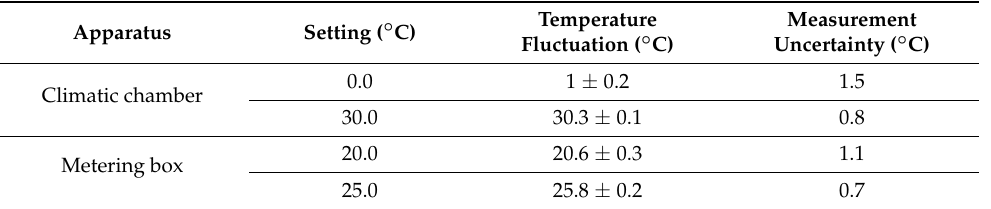
Table 2. Measurement uncertainties of climatic chamber and metering box.